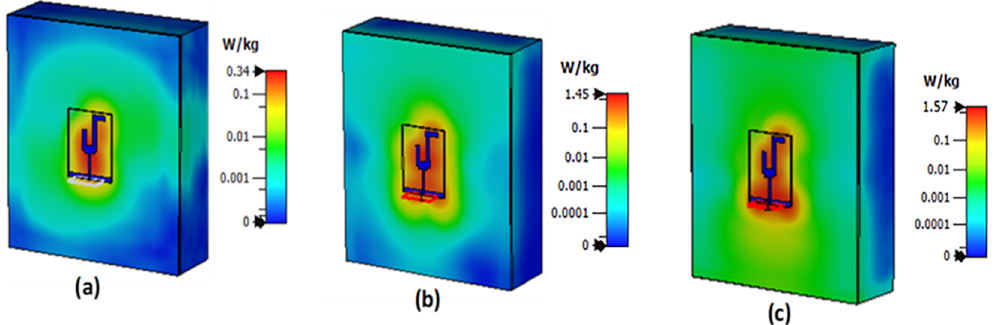
Figure 26. SAR 1g distribution for flat phantom ( a ) 2.45 GHz, ( b ) 5.8 GHz, and ( c ) 8.0 GHz.